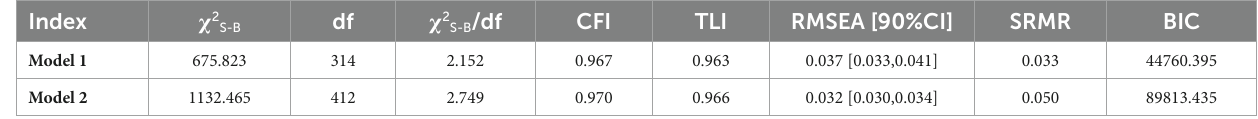
TABLE 5 Fit indices for the model 1 and model 2.